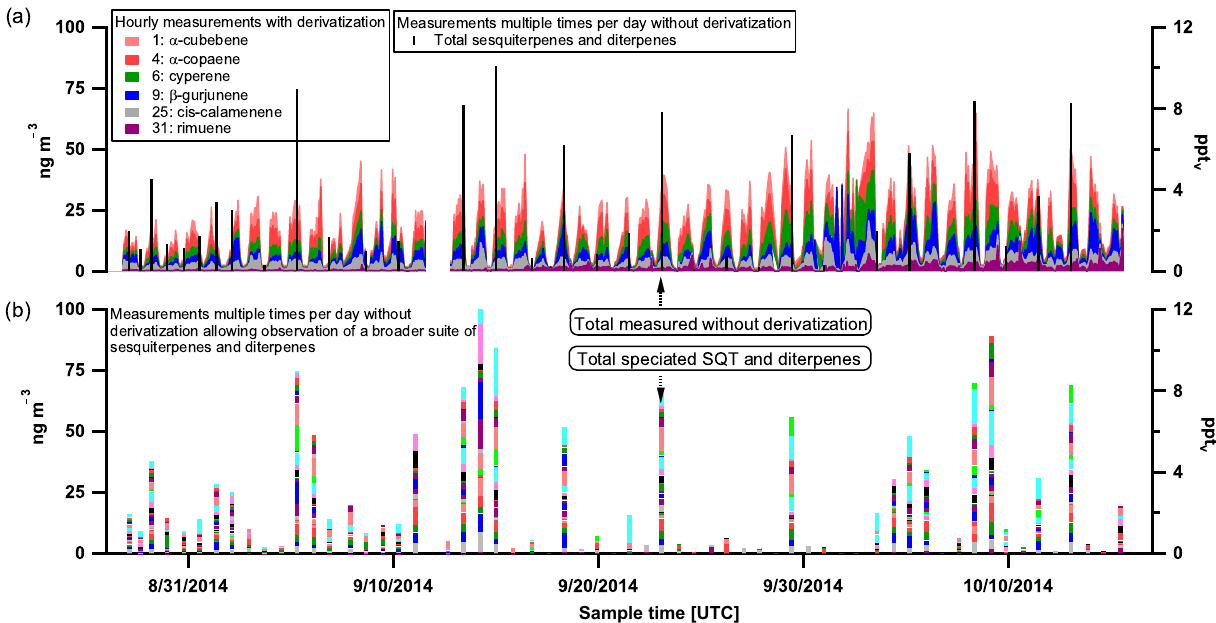
Figure 3. Dry season timeline of sesquiterpene (SQT) and diterpene species for those measured with hourly time resolution with deriva- tization (shaded colors) (a) and those measured multiple times per day at lower time resolution without derivatization (b) . Legend entries correspond to compound numbers in Table 1 and colors in (b) are the same used in Fig. 1b. Total SQTs and diterpenes quantified during runs without derivatization are overlaid in black for reference in panel (a) . Concurrent speciation shown in (b) .